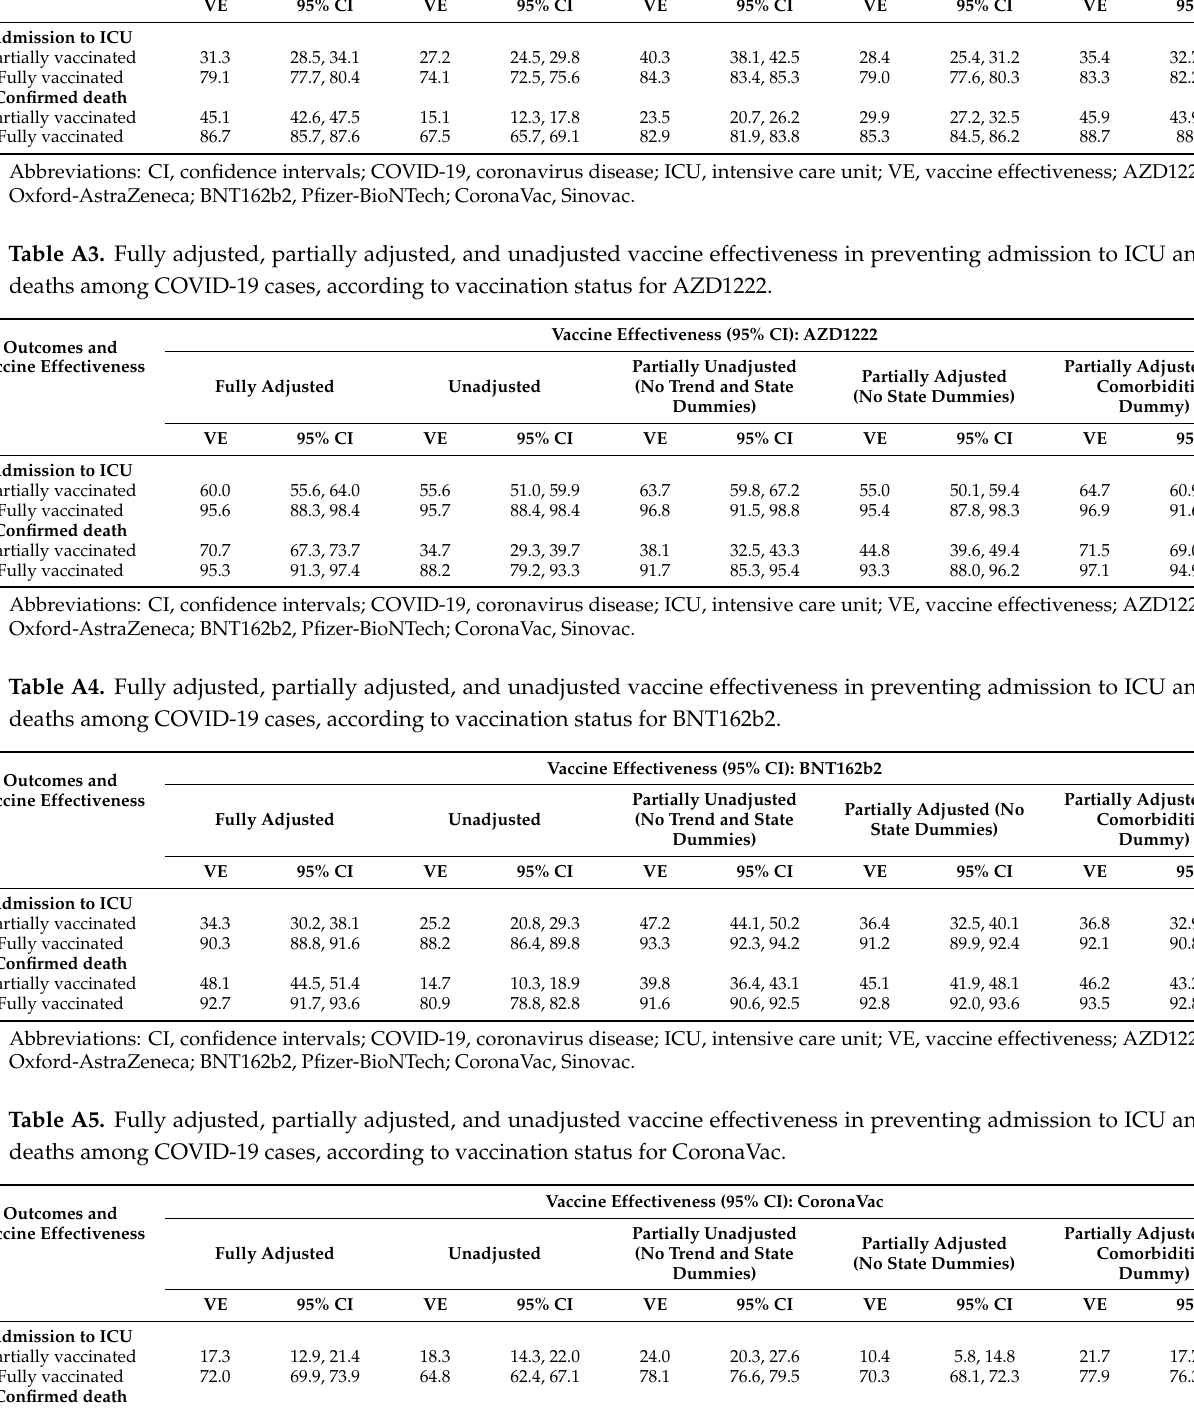
Outcomes and Vaccine Effectiveness